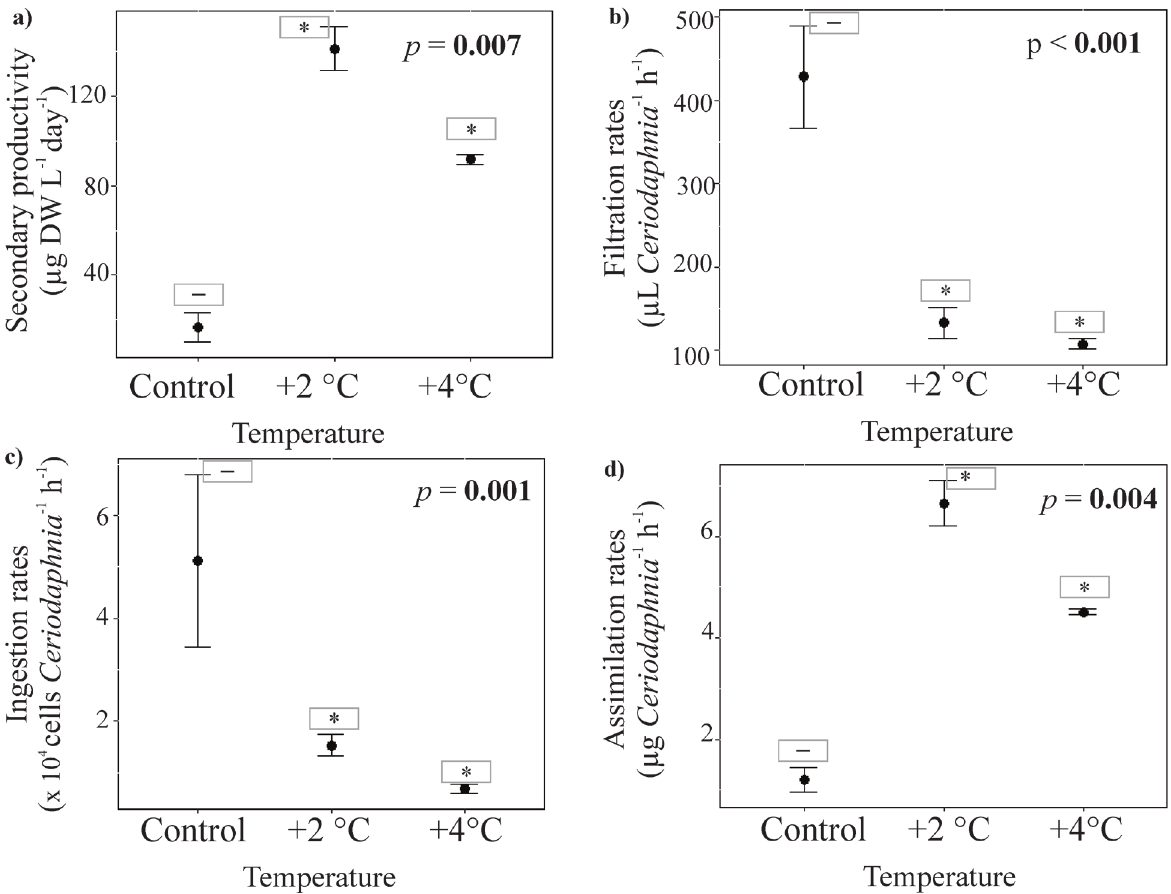
Figure 1. Box plot showing C. silvestrii metabolic rates, a) Secondary productivity, b) Filtration rates, c) Ingestion rates and d) Assimilation rates at three temperatures (control, +2 and +4°C), p-value from ANOVA analyses is shown. Symbols(-,*) above the columns indicate significant differences in post-hoc analyses - treatments that share a symbol do not differ significantly, p >0.05. • indicates the mean, ± standard error bars are